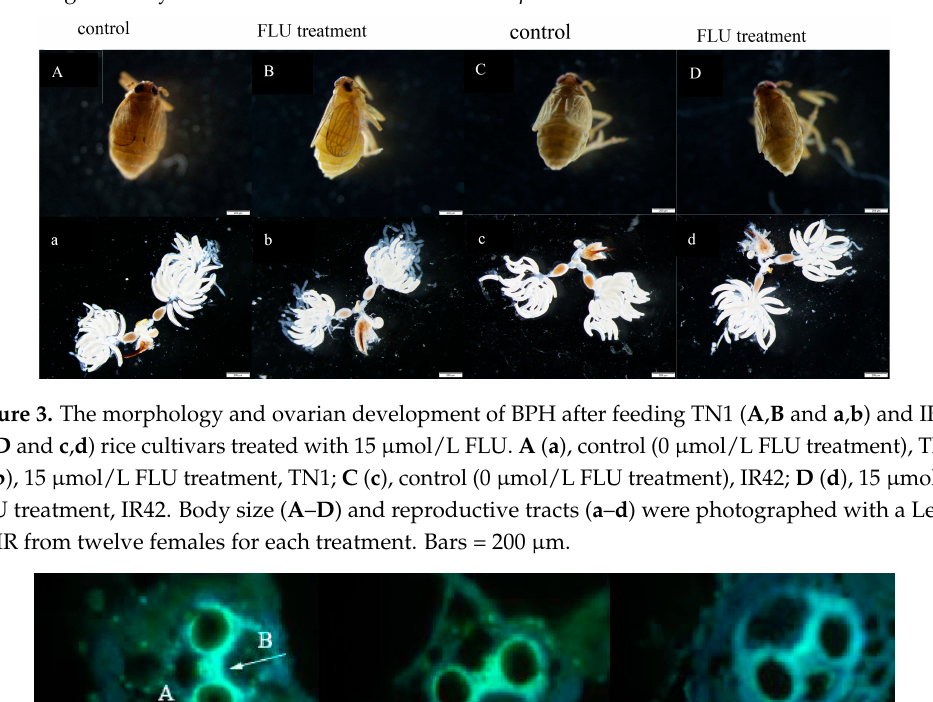
Figure 2. Changes of the fecundity, oviposition period and the expression level of Nlvg in female BPH after feeding TN1 and IR42 rice cultivars treated with FLU. Data was presented as means + SE. Means followed in the same rice cultivar by different letters indicated significant difference at the 5% level ( PLSD test, p < 0.05 level). Different letters in the bars showed the means of the same parameters differed significantly under the same rice cultivar at the p < 0.05 level.